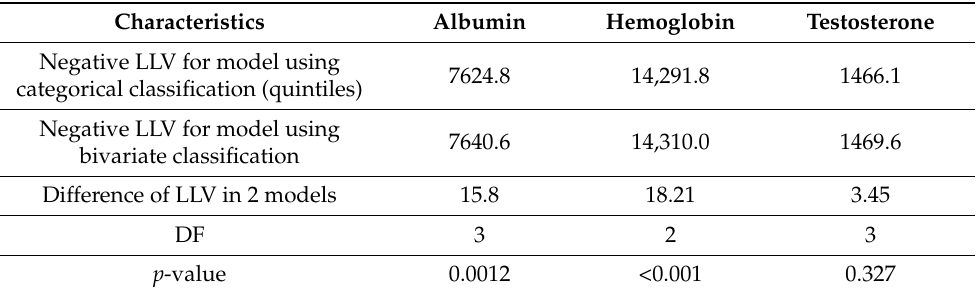
Table A4. Comparison of negative log-likelihood values of quintile-based model vs. model based on binary